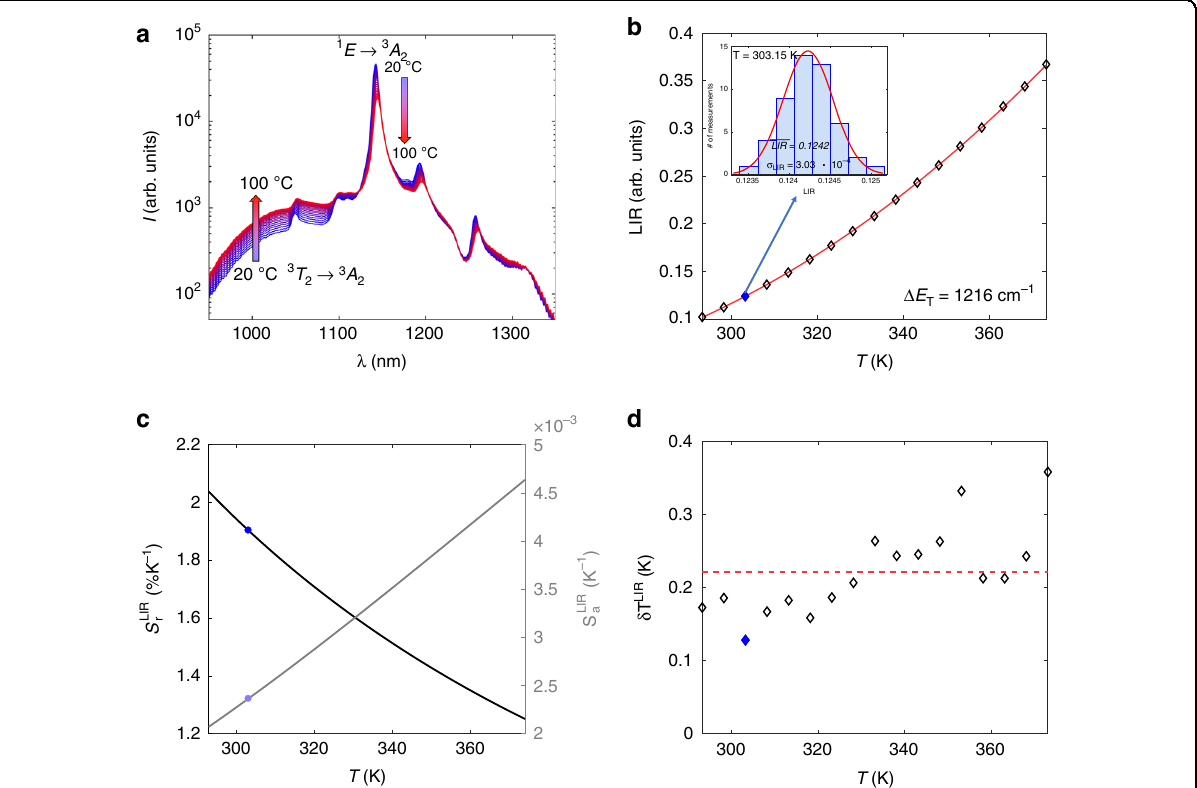
Fig. 5 Luminescence thermometry with Ca 6 Ba(PO 4 ) 4 O:Mn 5 + powder. a Photoluminescence emission spectra of Ca 6 Ba(PO 4 ) 4 O:Mn 5 + powder measured at different temperatures. b Luminescence intensity ratio (LIR) as a function of temperature (experimental data - diamond markers; fi t to Eq. (13) - full line). The insert shows the LIR distribution histogram measured at 303.15 K (30 °C) – fi lled diamond marker. c Calculated absolute and relative sensitivities (marked values at 303.15 K (30 °C)). d Experimentally obtained values for temperature resolution – fi lled diamond marker represents the value at 303.15 K (30